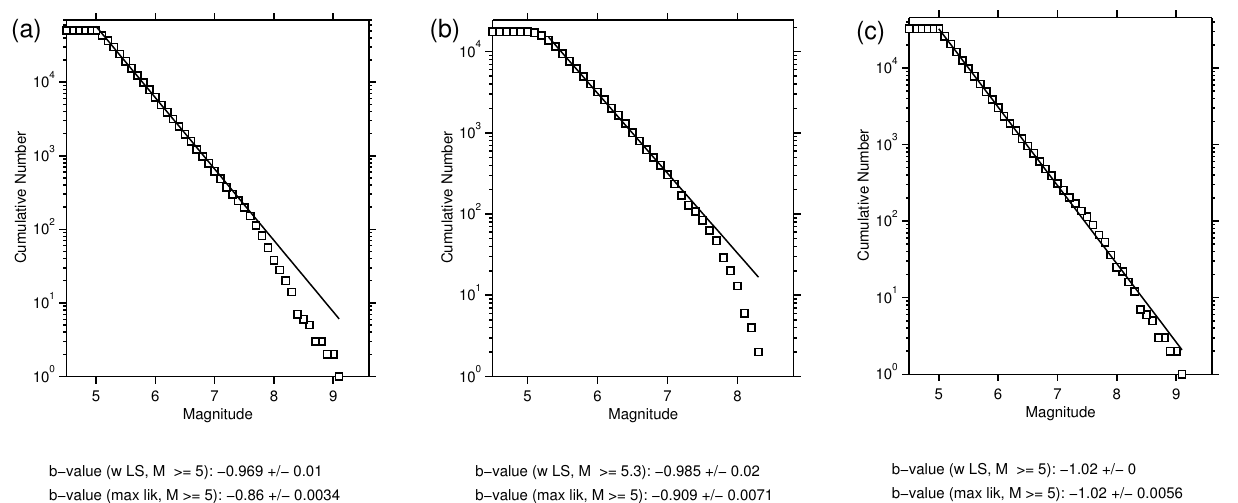
Figure 2. Frequency–magnitude diagram for earthquakes in the GCMT catalog. Estimated b-values with least squares (labeled ‘w LS’) and the maximum likelihood (labeled ’max lik’) method are also shown at the bottom of each panel. ( a ) For the whole study period (1976–2022), ( b ) for the period 1976–2000, and ( c ) for the period 2001–2022, using the ZMAP software [93]. The number of earthquakes is counted in bins of 0.1-magnitude-unit